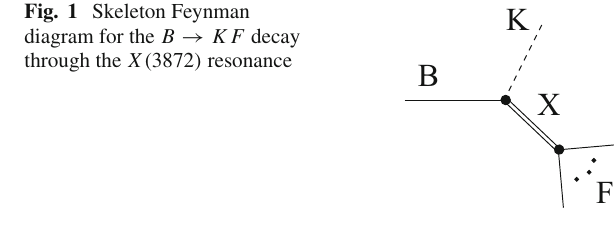
Fig. 1 Skeleton Feynman diagram for the B → K F decay through the X ( 3872 ) resonance B